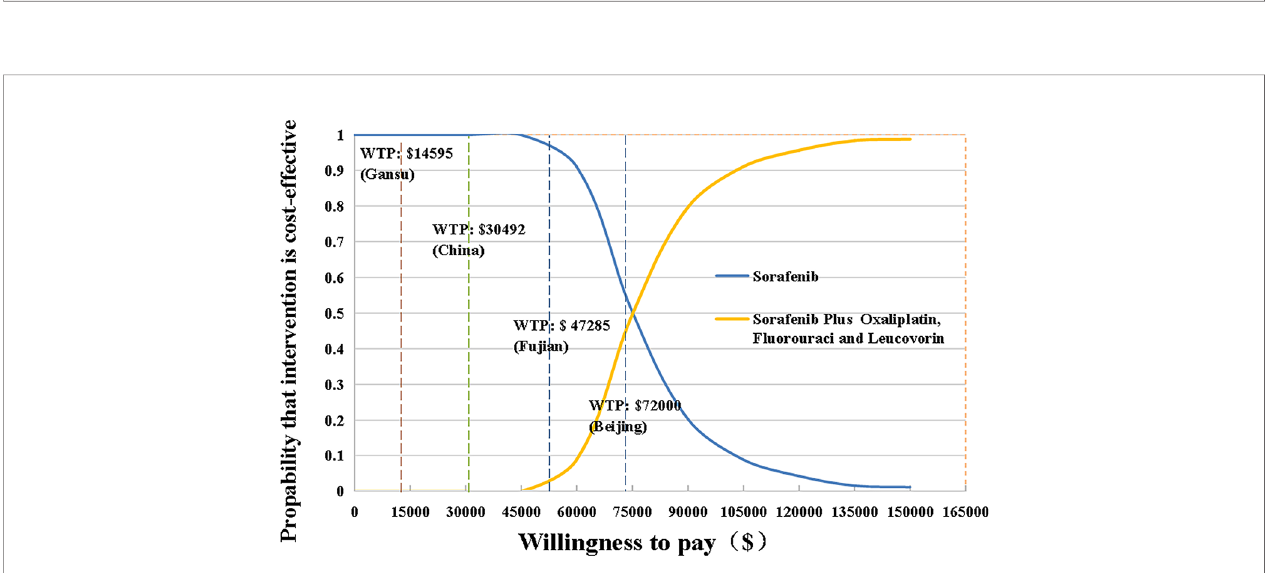
FIGURE 2 | The cost-effectiveness acceptability curves for HAIC plus sorafenib strategy compared to the sorafenib strategy. HAIC, hepatic arterial infusion chemotherapy; WTP, willingness-to-pay.